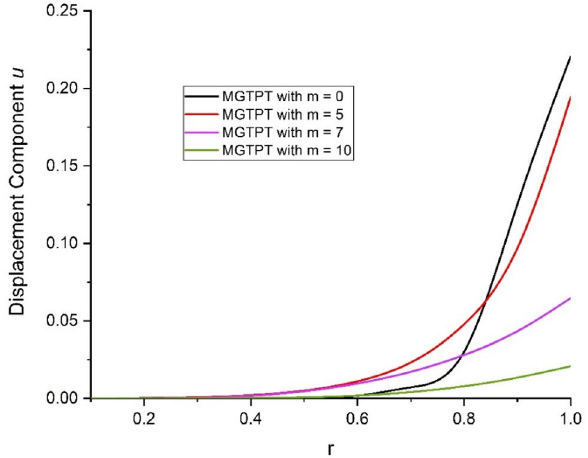
Fig. 2 The displacement deviation with Hall Effect under